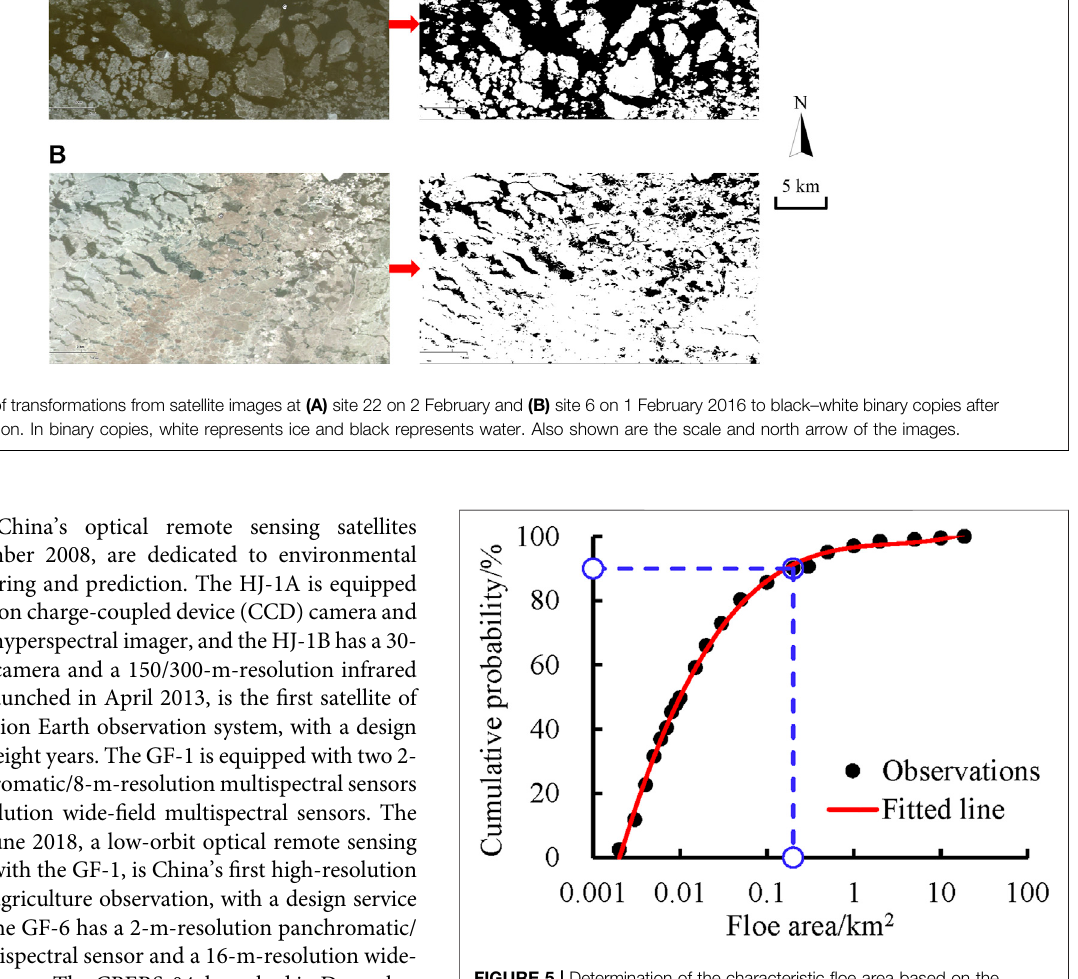
FIGURE 5 | Determination of the characteristic fl oe area based on the satelliteimageatsite5on10February2017.Thecharacteristic fl oeareaofthis case is 0.20 km 2